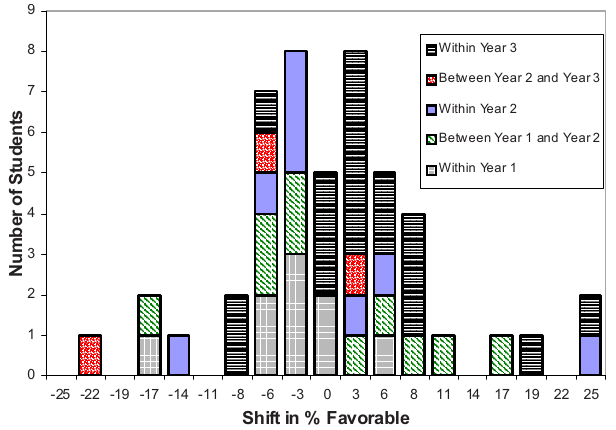
FIG. 2. (cid:1) Color (cid:2) Histogram of the percent shift in favorable scores for multiply surveyed students. Shift calculated using first and second surveys.